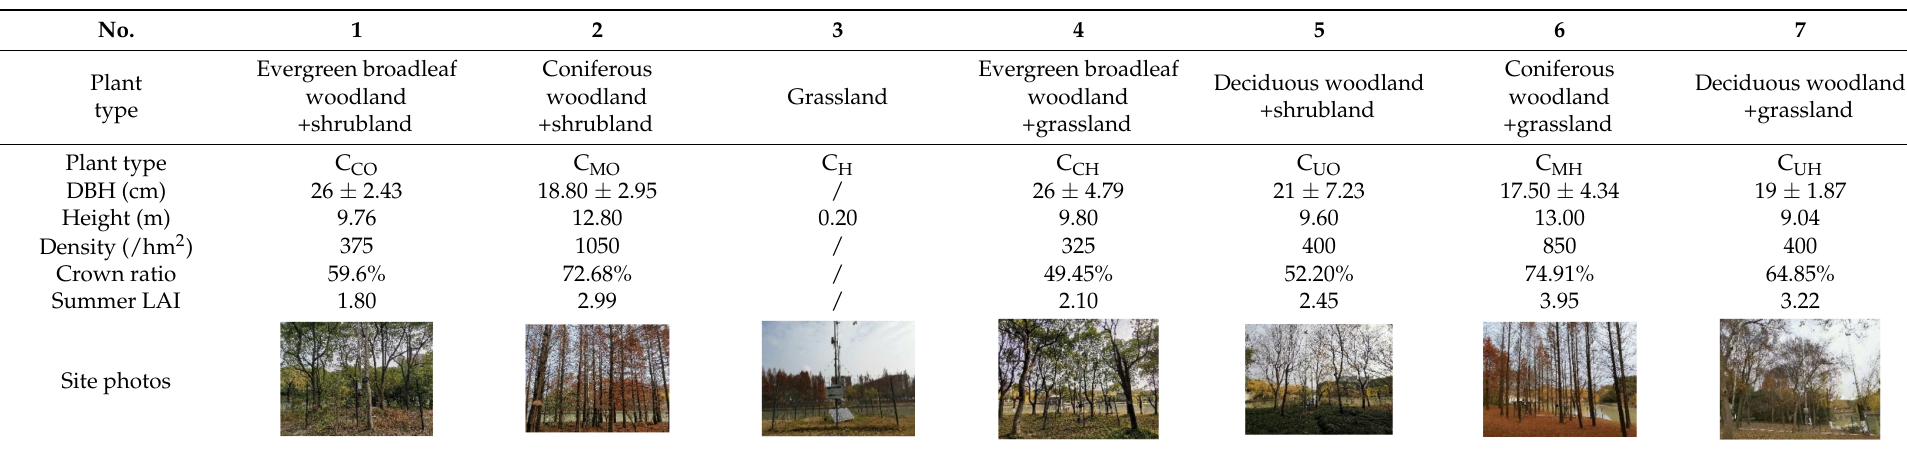
Table 1. Plant communities in each riparian site along the Danshui River,